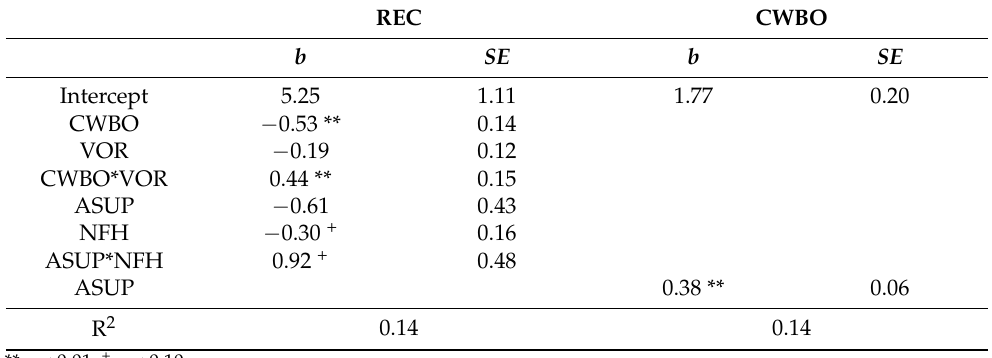
Figure 4. NFH Moderation Effect.